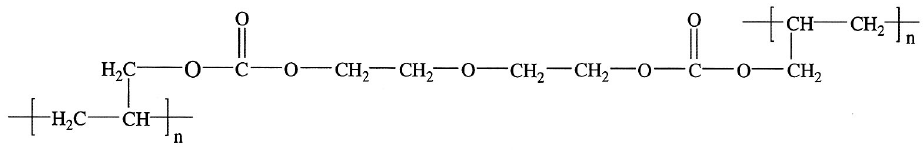
Figure 1. A repeat-unit of PADC.